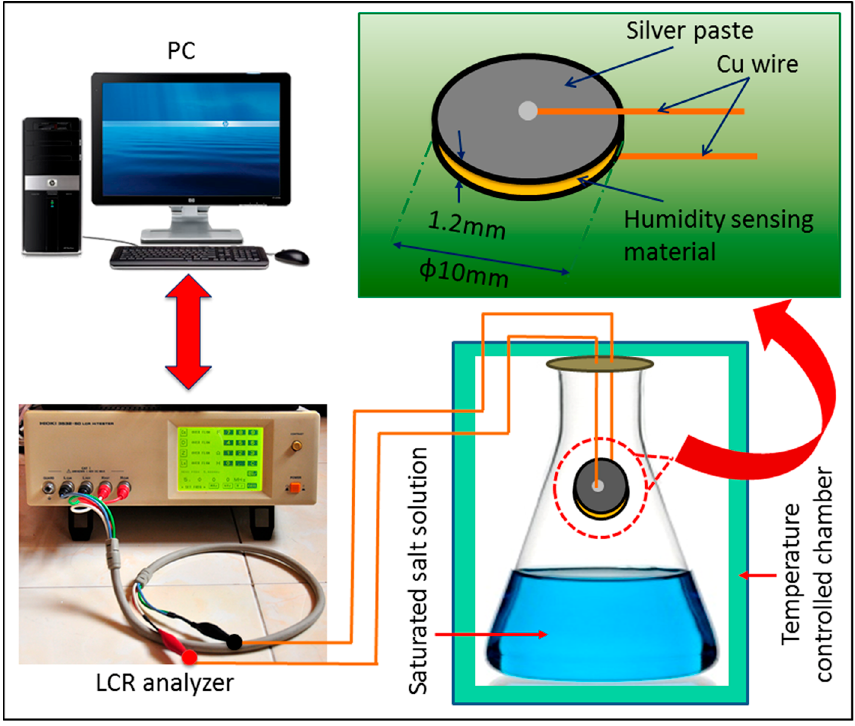
Figure 2. Experimental setup for the measurement of the capacitive humidity response of the electro-ceramic based sensors.